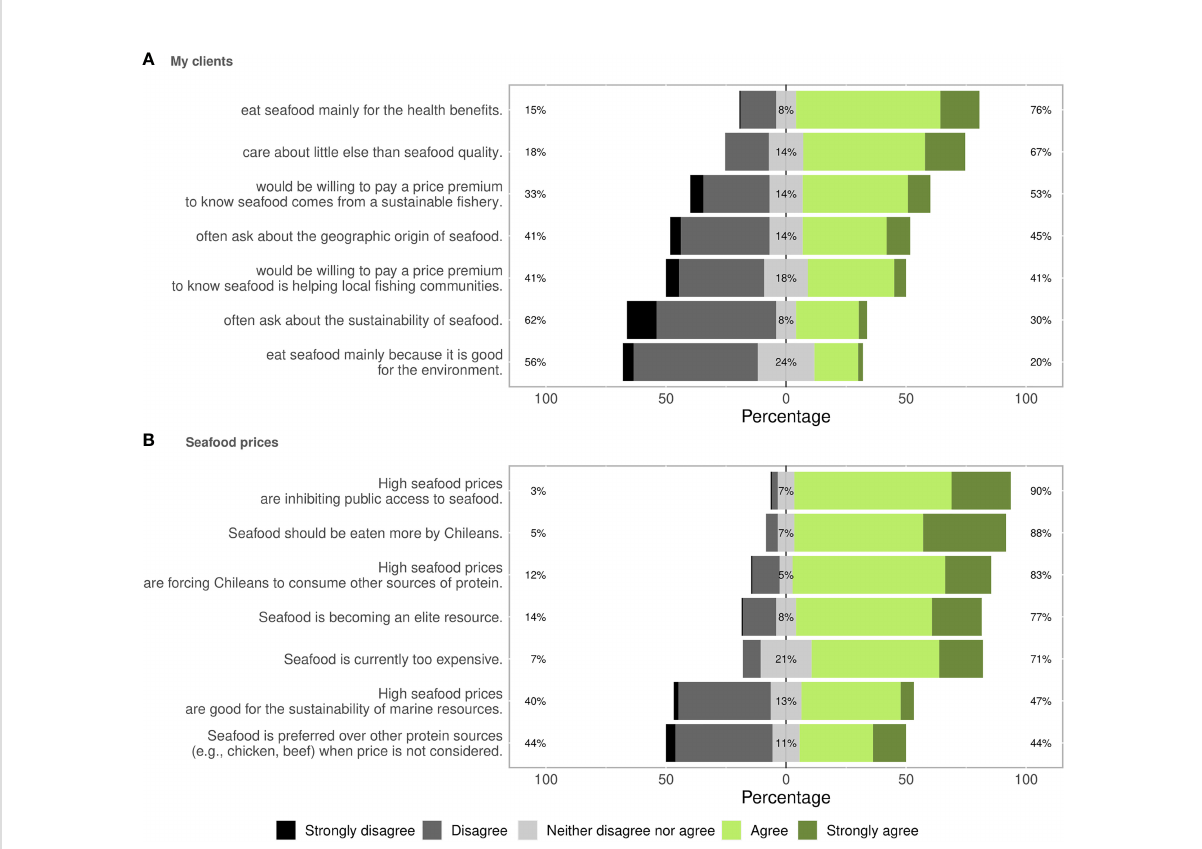
FIGURE 2 Chilean restauranters ’ perceptions on (A) their clients and (B) the cost of seafood. All survey questions were answered on 5-point Likert scale. The percentages on the left and right represent the sum of strongly disagree + disagree and strongly agree + agree,